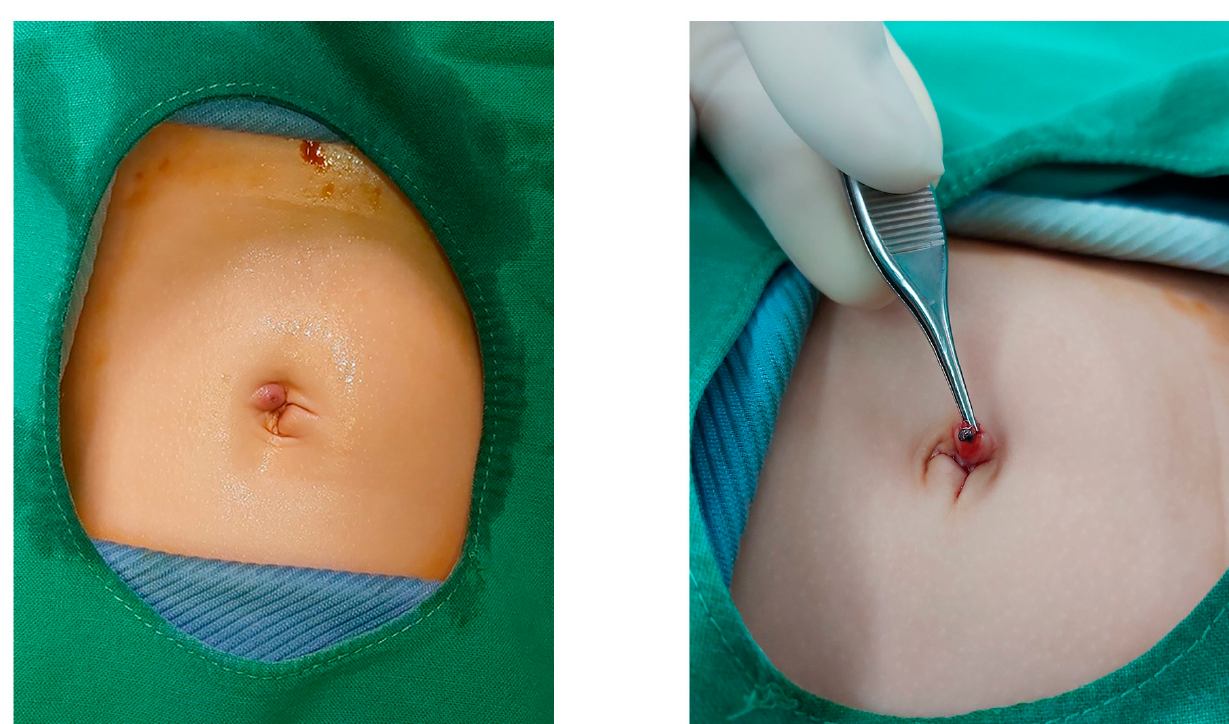
Figure 3. Stich reactions causing omphalitis.